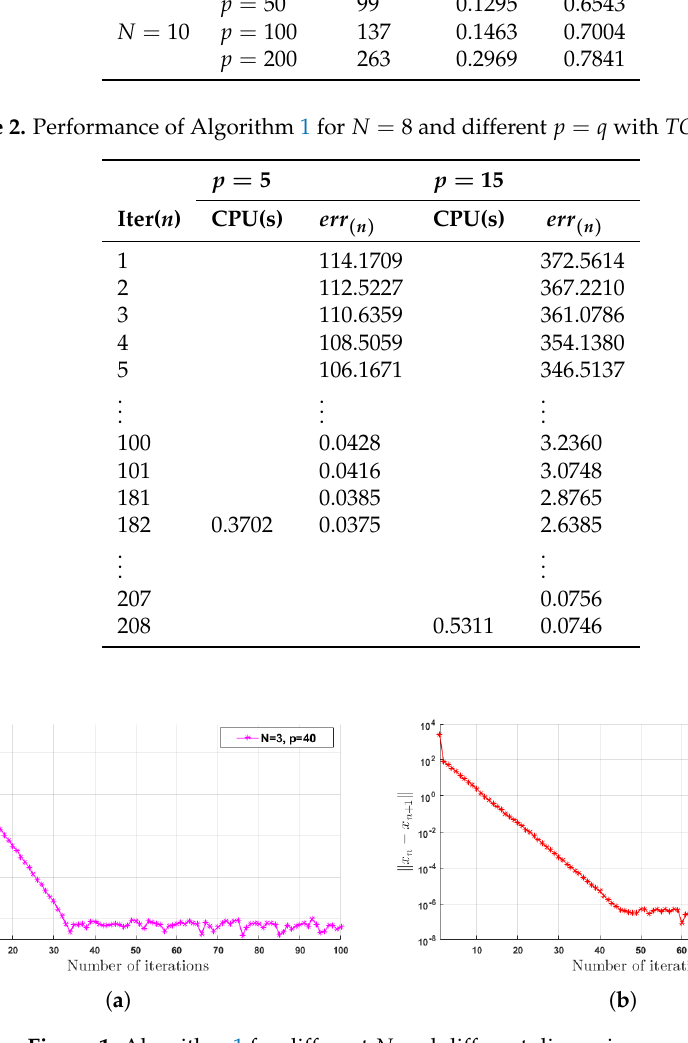
Figure 1. Algorithm 1 for different N and different dimensions p = q